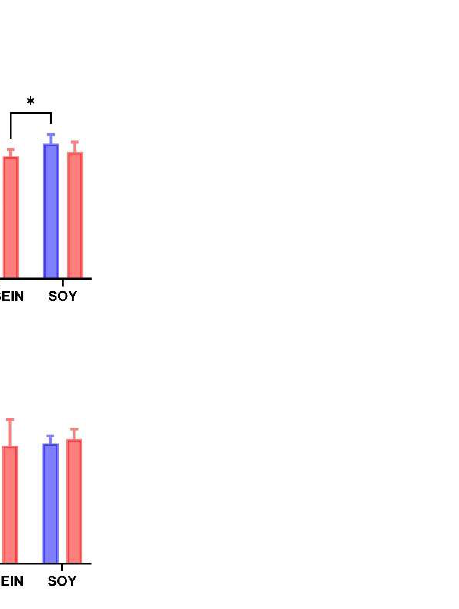
Figure 6. Effects of chronic ethanol and dietary soy isolate on Notch pathway protein expression. Duplex ELISAs were used to measure ( A ) Notch-1; ( B ) Jagged-1; ( C ) HES-1, and ( D ) HIF-1α (N = 12/group). Immunoreactivity was detected with horseradish peroxidase-conjugated secondary an- tibody and Amplex UltraRed soluble fluorophore. Results were normalized to large acidic riboso- mal protein (RPLPO) (See Methods). Graphed data reflect the mean ± S.D. of immunoreactivity and were analyzed using two-way ANOVA tests (Table 5) with post hoc Tukey tests. Significant p -Val- ues are indicated above the bars. * p < 0.05.